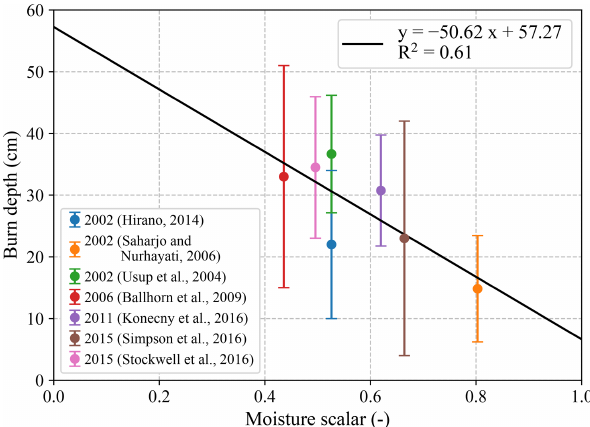
Figure 1. Parameterization of burn depth in tropical peatlands ( D burn_tropics ) as a function of the soil moisture scalar. The tropical peat burn depth was based on a linear regression function derived from the relationship between field measurements of burn depth and the soil moisture scalar, ε SM0 − 100cm . The soil moisture scalar was based on the depth-weighted average volumetric soil water content over the ERA5-land model depths of 0–7, 7–28, and 28–100cm (Muñoz Sabater,